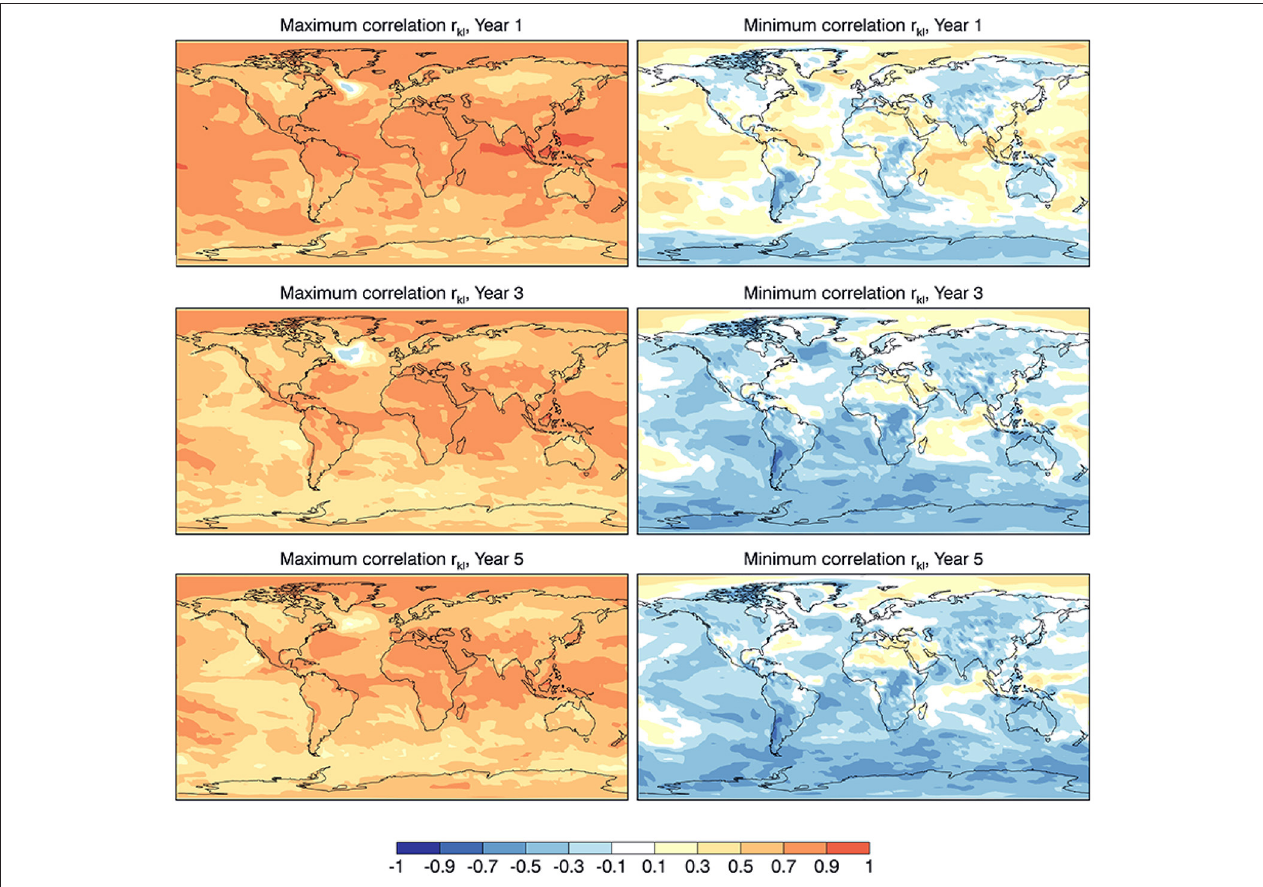
FIGURE 10 | The local maximum and minimum correlation skill r kl between individual members of the reanalysis X k and forecast Y l ensembles for Year 1, 3, and